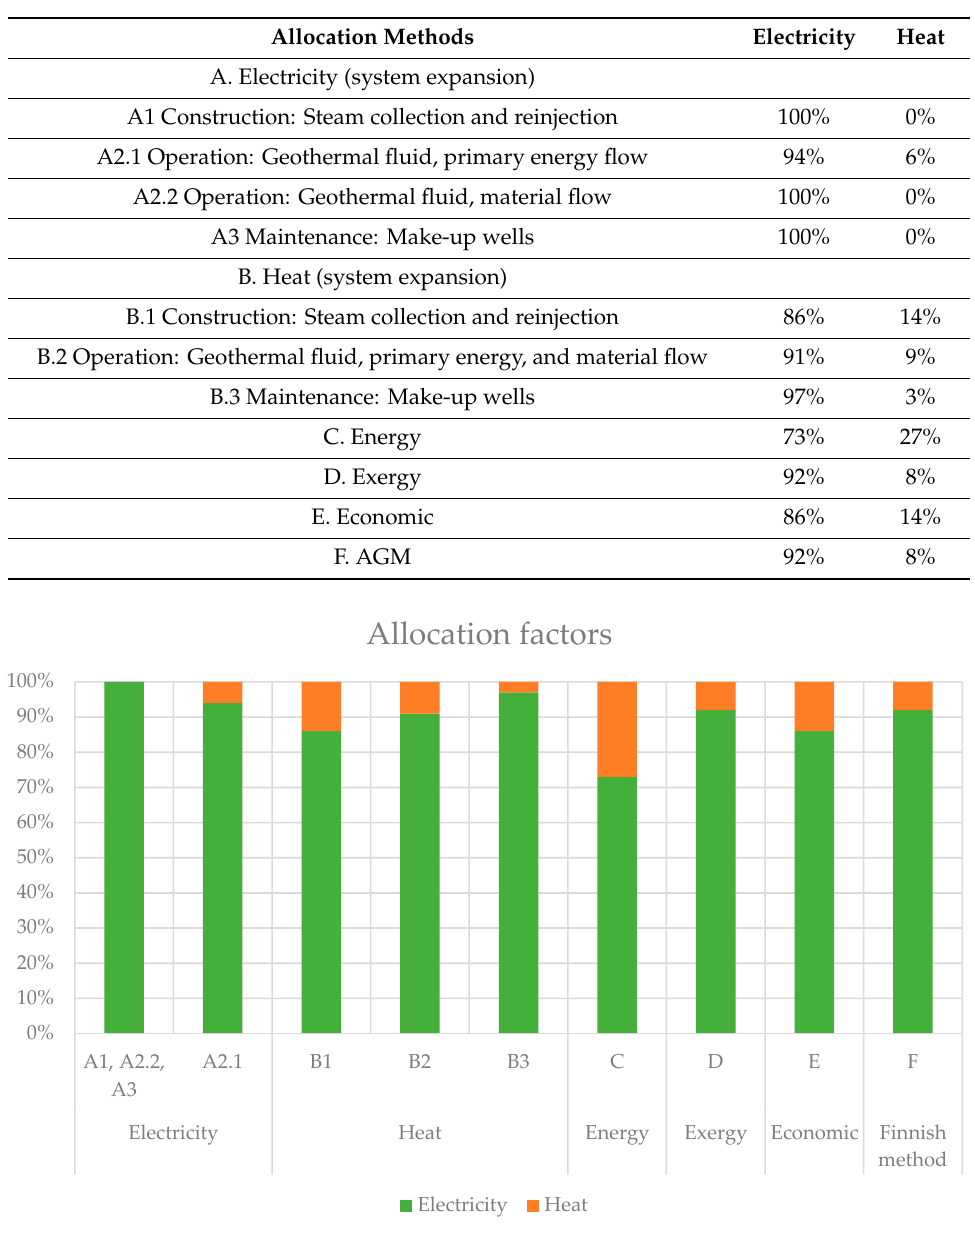
Figure 4. Results for allocation factors for electricity and heat from the Hellisheidi CHP plant based on the investigated allocation methods.